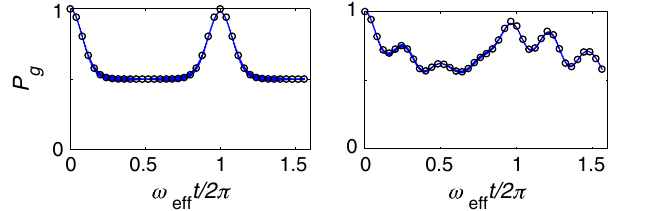
ð t Þ obtained by integrating the exact Hamiltonian FIG. 2. P g equation, (3), (light solid line, shaded area), and after applying an additional drive pulse (dark solid). Both are compared to the effective (circles) Hamiltonian equation, (6), evolution. The same parametersofFig.1areused:leftpanel: (cid:1) 2 ¼ 0 ,rightpanel: (cid:1) 2 ¼ 2 (cid:2) (cid:6) 10 MHz . During the additional drive pulse, qubit energy and driving frequency are detuned by (cid:1) 2 (cid:2) (cid:6) 200 MHz